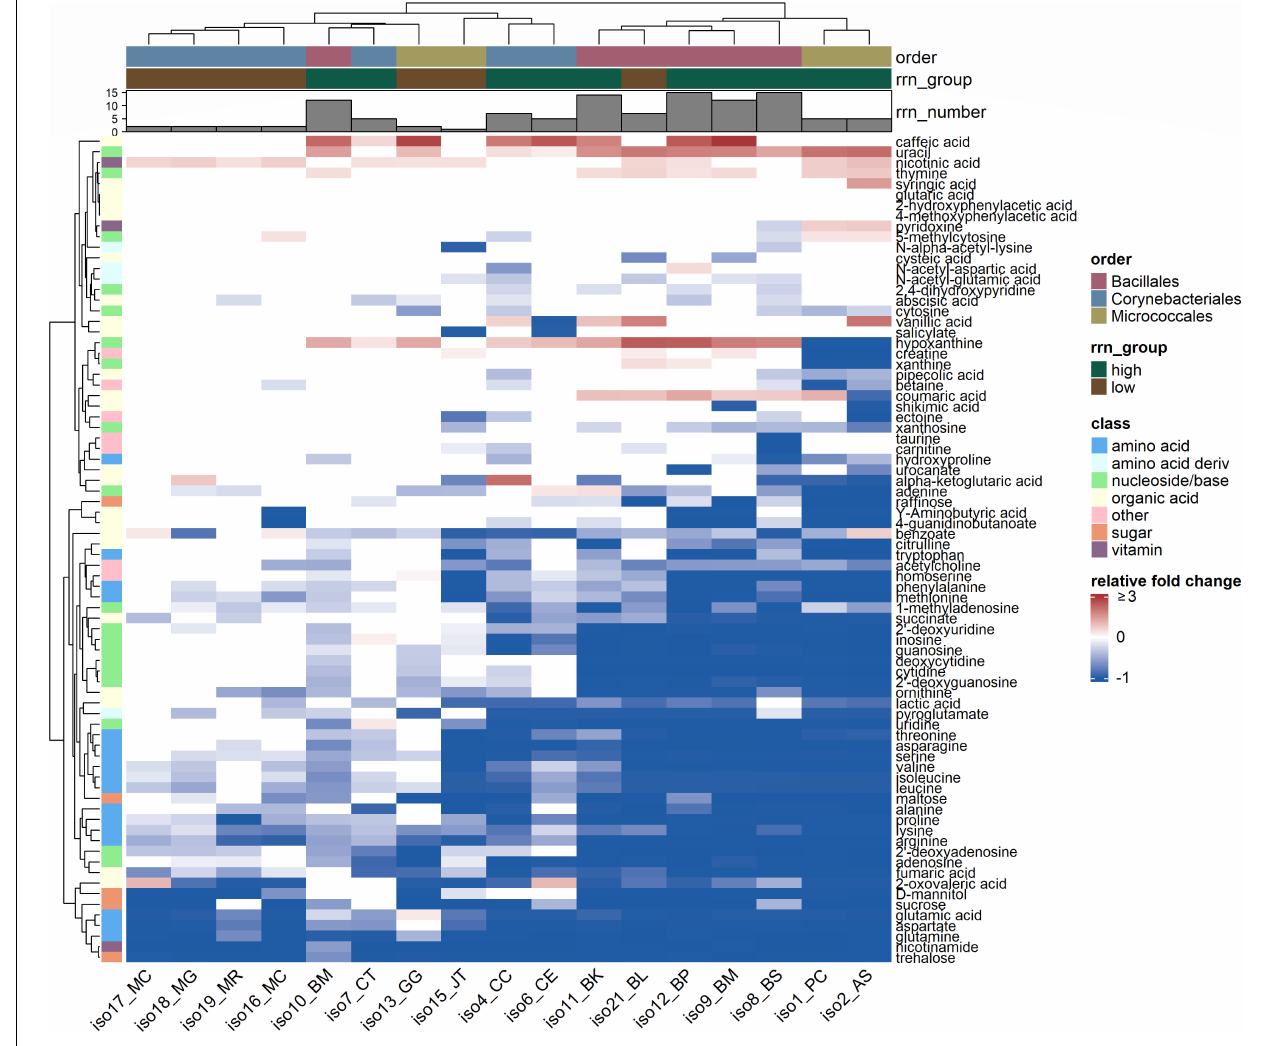
Frontiers in Microbiology |